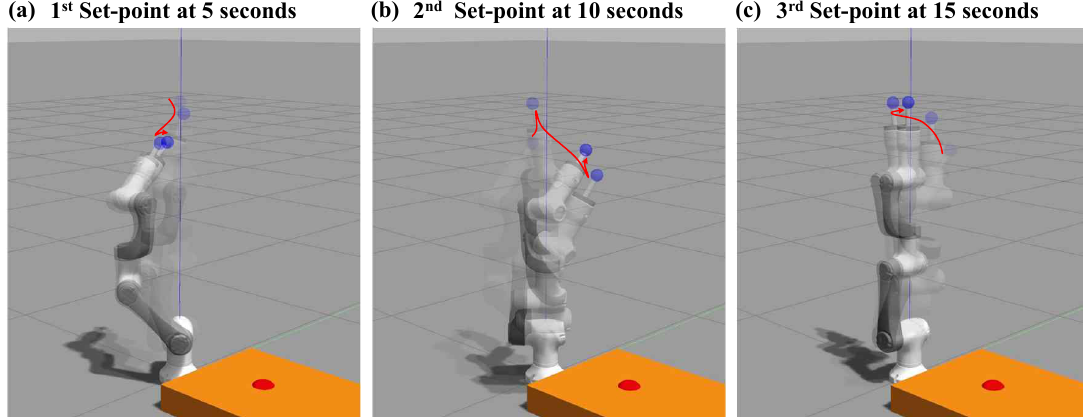
Figure 4. Snapshots of simulation result according to time progress, where the robotic manipulator used in the simulation is Neuromeka Indy5 having 6-DoFs. The ball-shaped load model denoted by a blue color provides the external force to the manipulator. The initial posture was upright, and, first target was given by q d , i = π for all joints i = 1,2, · · · ,6 at the instant of 5 s, and then the target was 4 changed into q d , i = − π at the instant of 10 s, and finally, the target was recovered to the initial upright 4 posture at the instant of 15